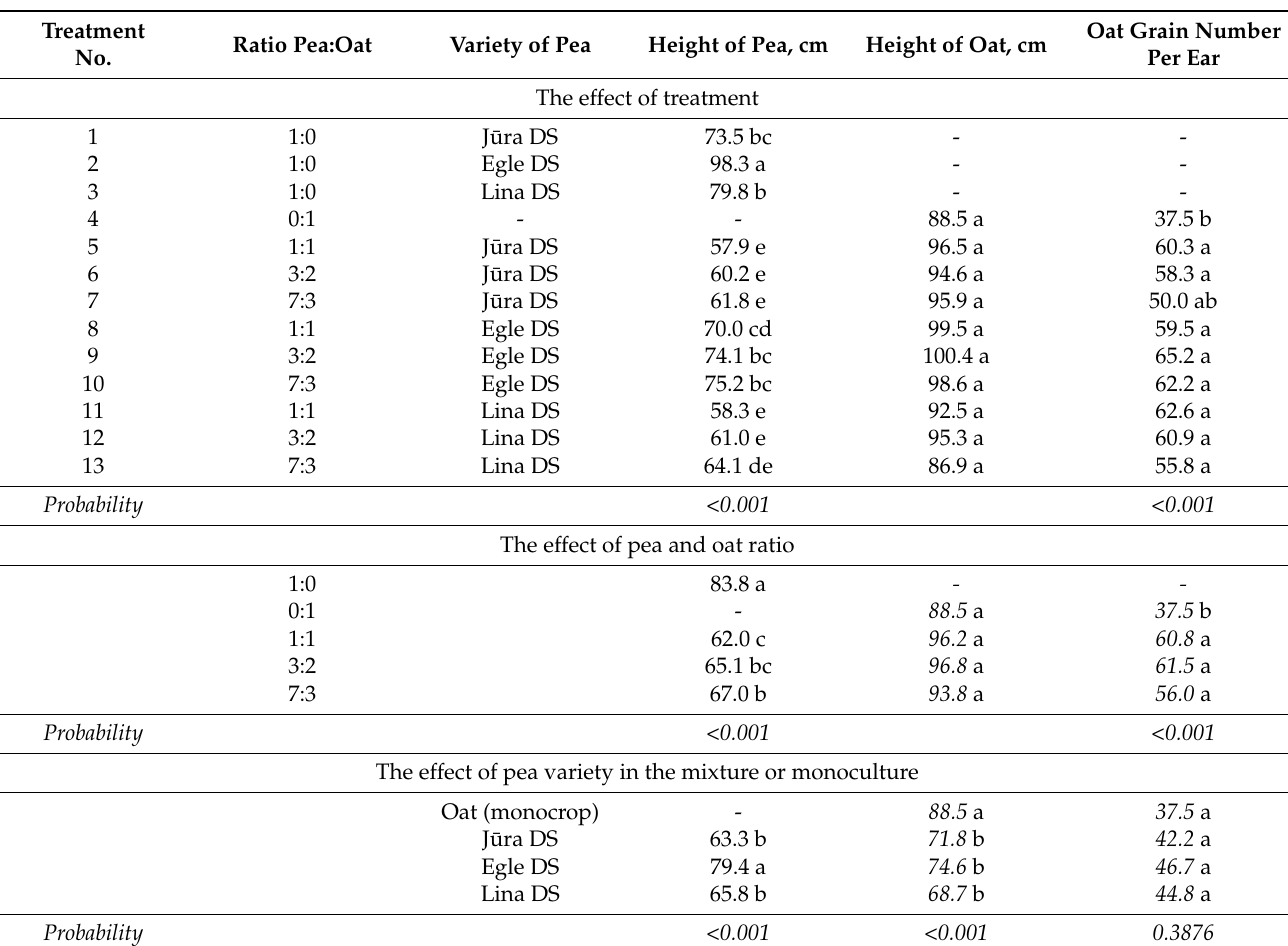
Table 2. Crop height and number of oat grains per ear, averaged across the three years, depending on the pea sowing rate and the different